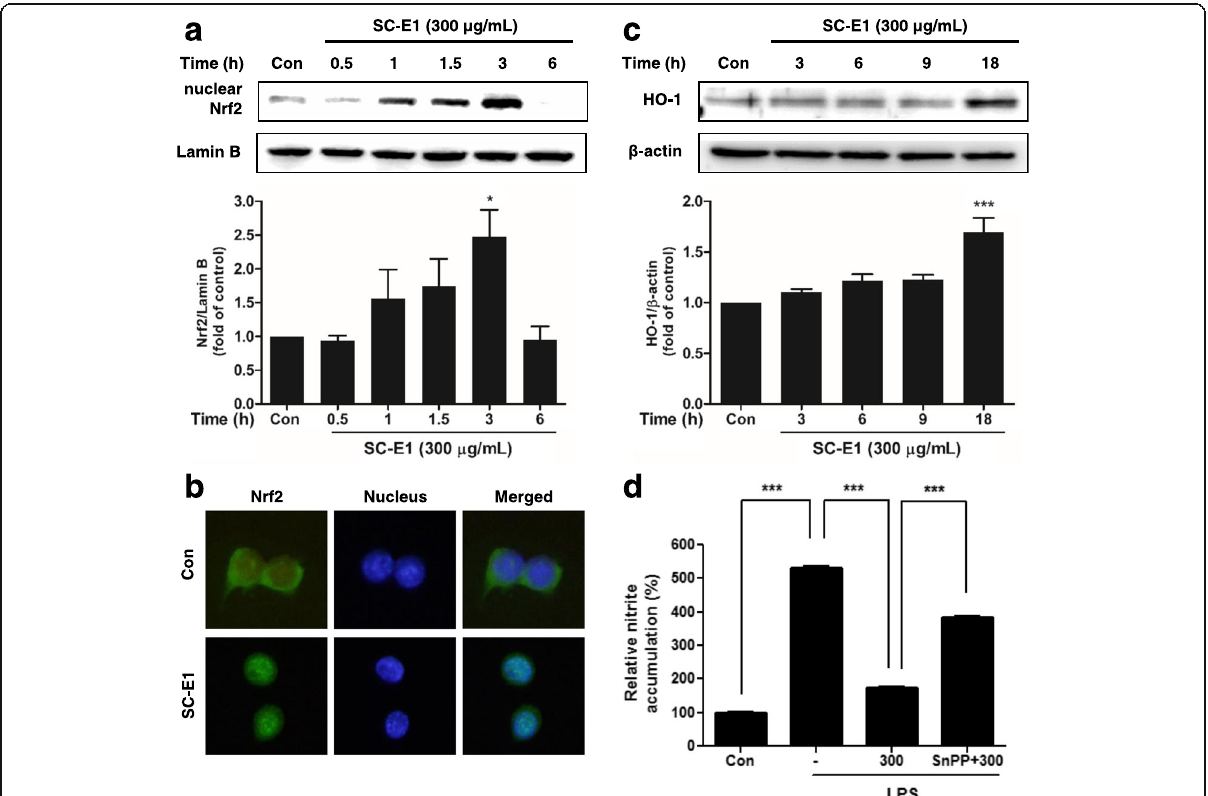
Fig. 7 Effects of SC-E1 on the Nrf2 activation in RAW 264.7 macrophages. a Nuclear accumulation of Nrf2. Nrf2 was immunoblotted in the nuclear fractions of the cells treated with 300 μ g/ml of SC-E1 for 0.5 – 6 h. Immunoblotting for Lamin B verified the equal loading of nuclear proteins. Each experiment conducted for 3 repeats per conditions. (Significant compared to the control, * p < 0.05 and *** p < 0.001.) b Immunofluorescence. RAW 264.7 cells were treated with 300 μ g/ml of SC-E1 for 3 h. The staining of Nrf2 and DAPI was conducted as described in the method section. c Immunoblotting for HO-1. The HO-1 was immunoblotted in the RAW 264.7 cells that had been treated with 10 – 300 μ g/ml of SC-E1 for 3 h. d Inhibitory effects of SC-E1 pretreatment and co-pretreatments with SC-E1 and SnPP (a HO-1 inhibitor) on the LPS-induced production of nitrite. RAW 264.7 cells were pretreated with SC-E1 ( μ g/ml) for 1 h in the presence or absence of SnPP (50 nM, 30 min), and then stimulated with LPS (1 μ g/ml) for 24